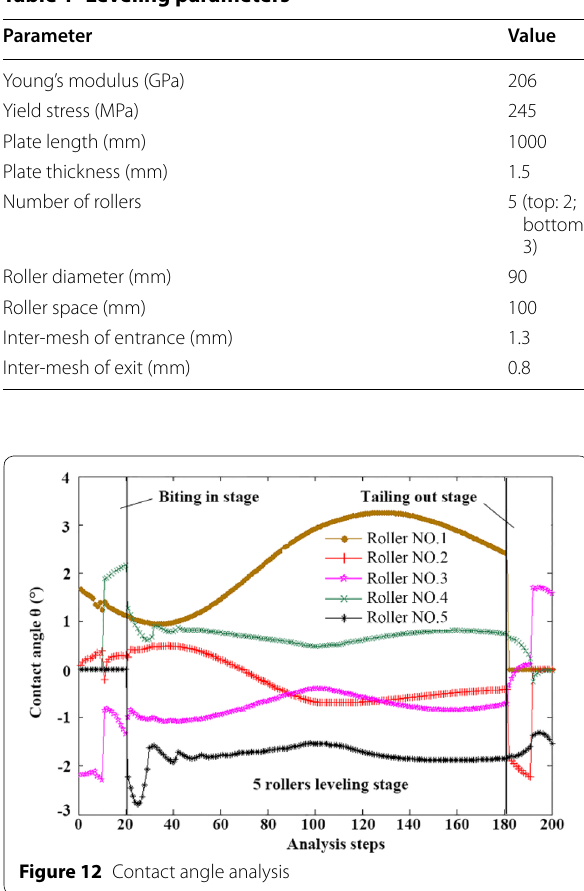
Figure 12 Contact angle analysis